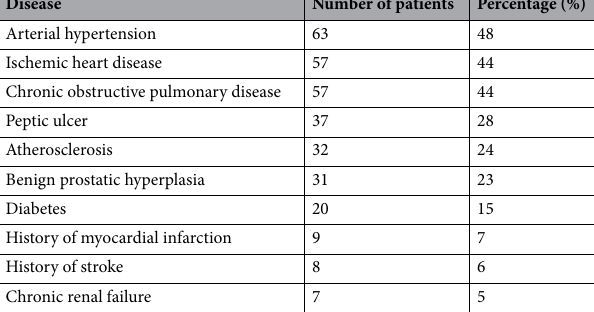
Disease Number of patients Percentage